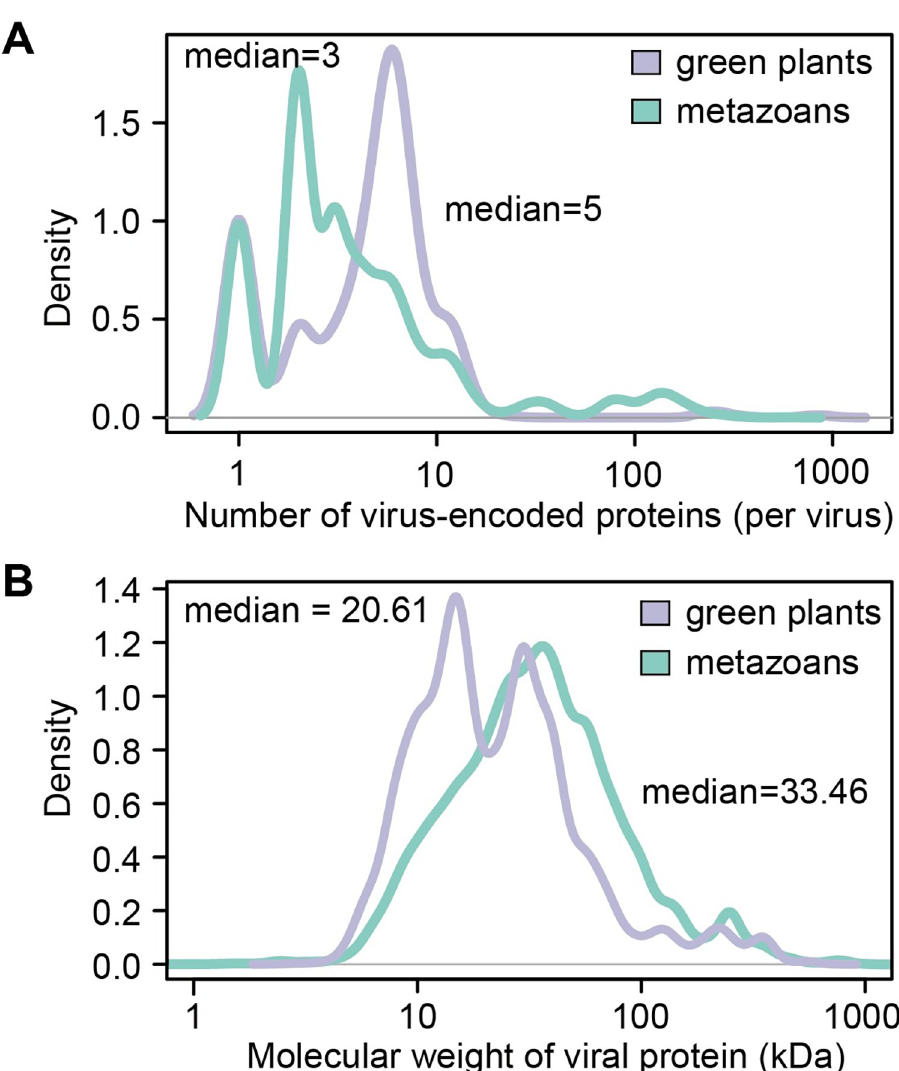
Fig 1. Average number of virus-encoded proteins and their molecular weight. (A) Average numbers of virus- encoded proteins (per virus) in animal and plant viruses. (B) Molecular weight of viral proteins from animal and plant viruses. Sequences in (A and B) were downloaded from NCBI Virus, from complete RefSeq genome sequences of viruses infecting Viridiplantae (green plants, taxid: 33090) or Metazoa (metazoans, taxid: 33208).